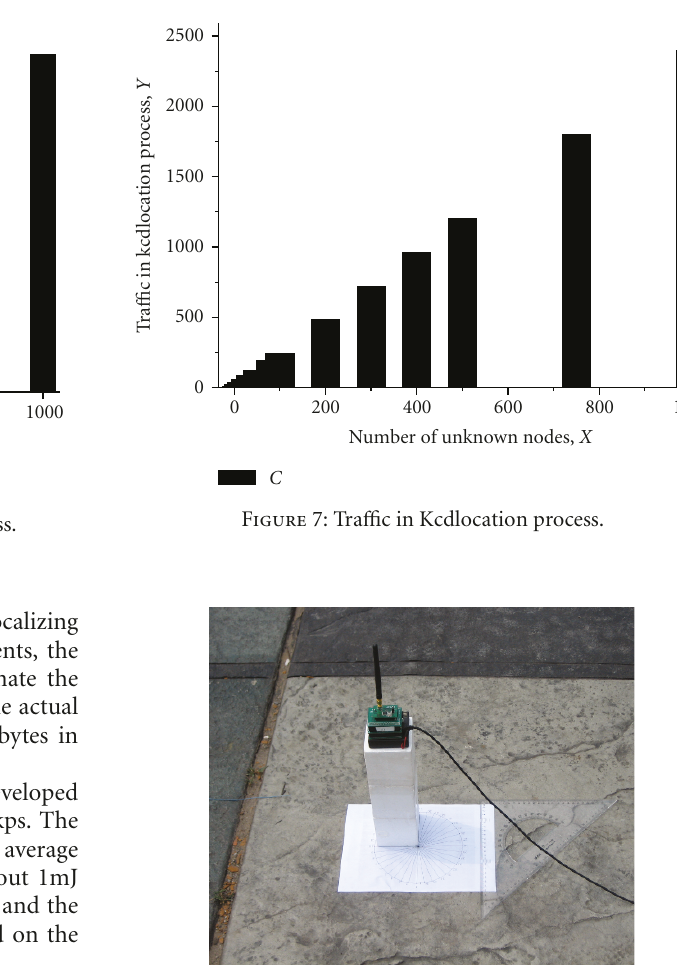
Figure 8: SKLTT node onto a public square for the experimental